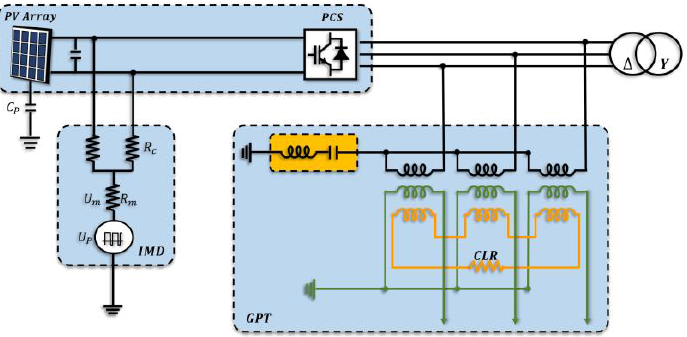
Figure 8. Method of cooperative use of IMD and GPT.